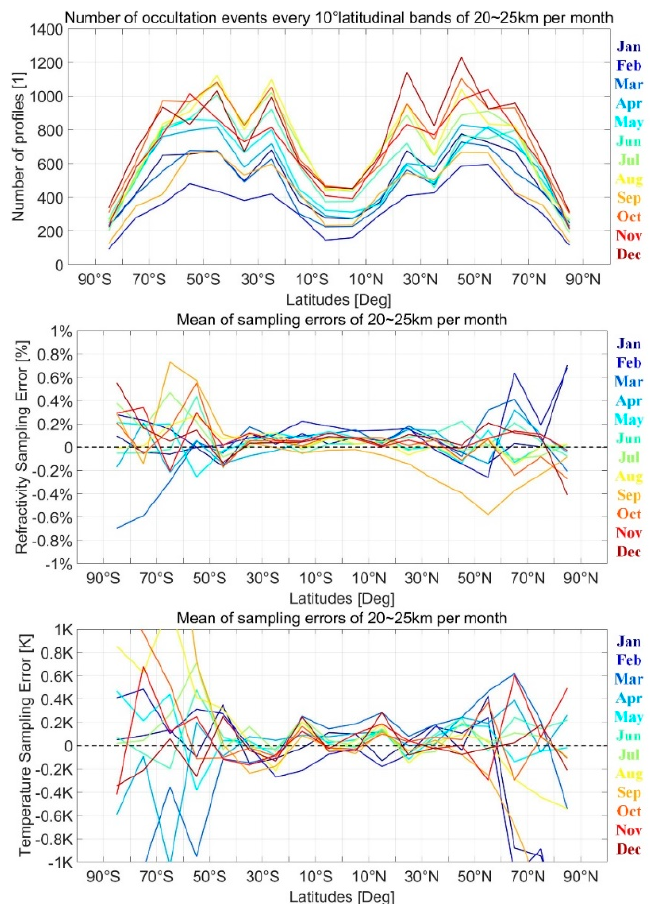
Figure 9. Refractivity and temperature sampling errors for January (left panels) and July (right panels) of 2017 with 10° latitudinal interval bands.